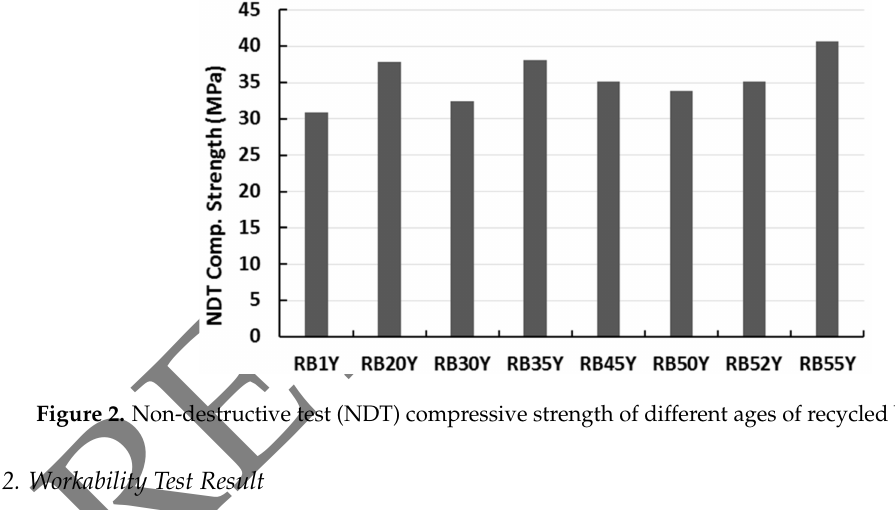
Figure 2. Non-destructive test (NDT) compressive strength of different ages of recycled brick